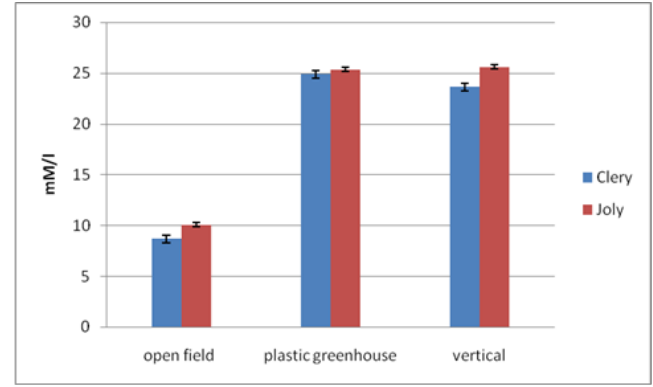
Figure 1. The average antioxidant values in 2016 in the case of the three cultivation technologies.